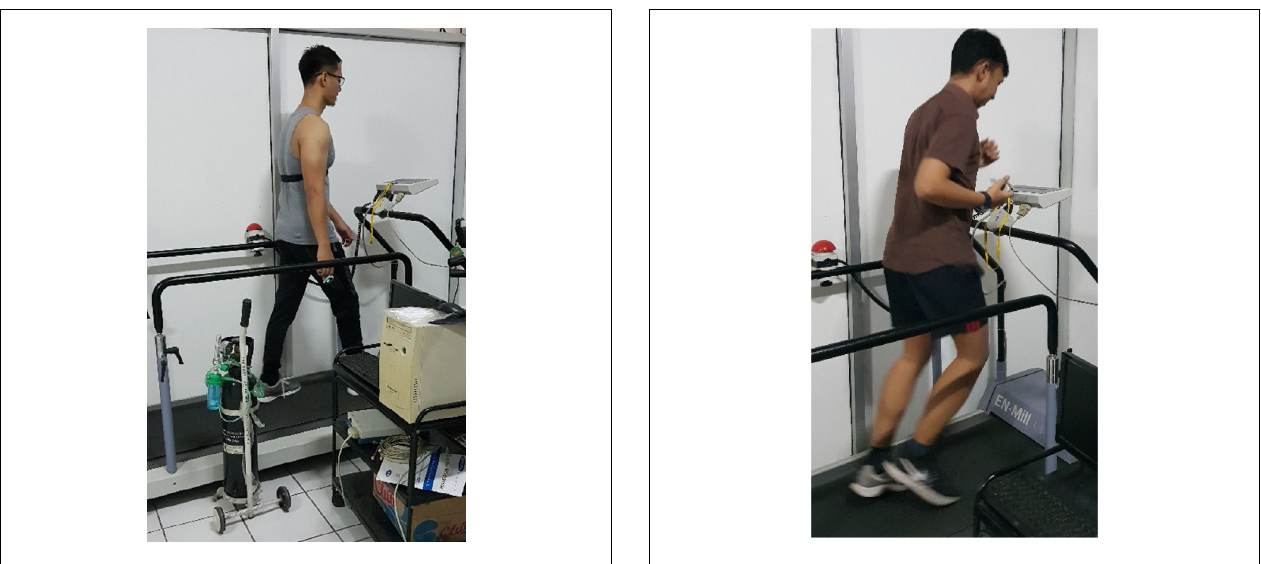
Academic Hospital Surabaya Indonesia with ethical clearance no. 0206/KEPK/IV/2018.